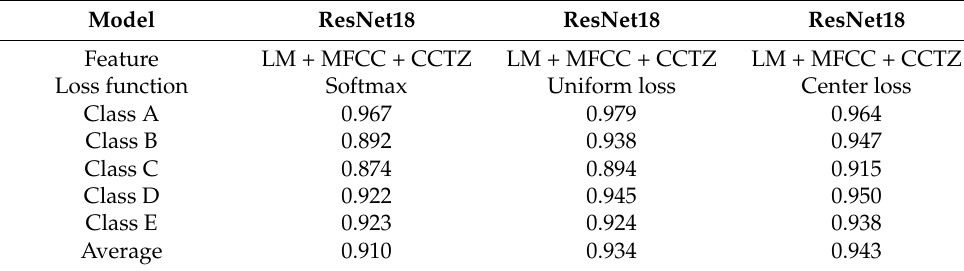
Table 6. The comparison of the different loss